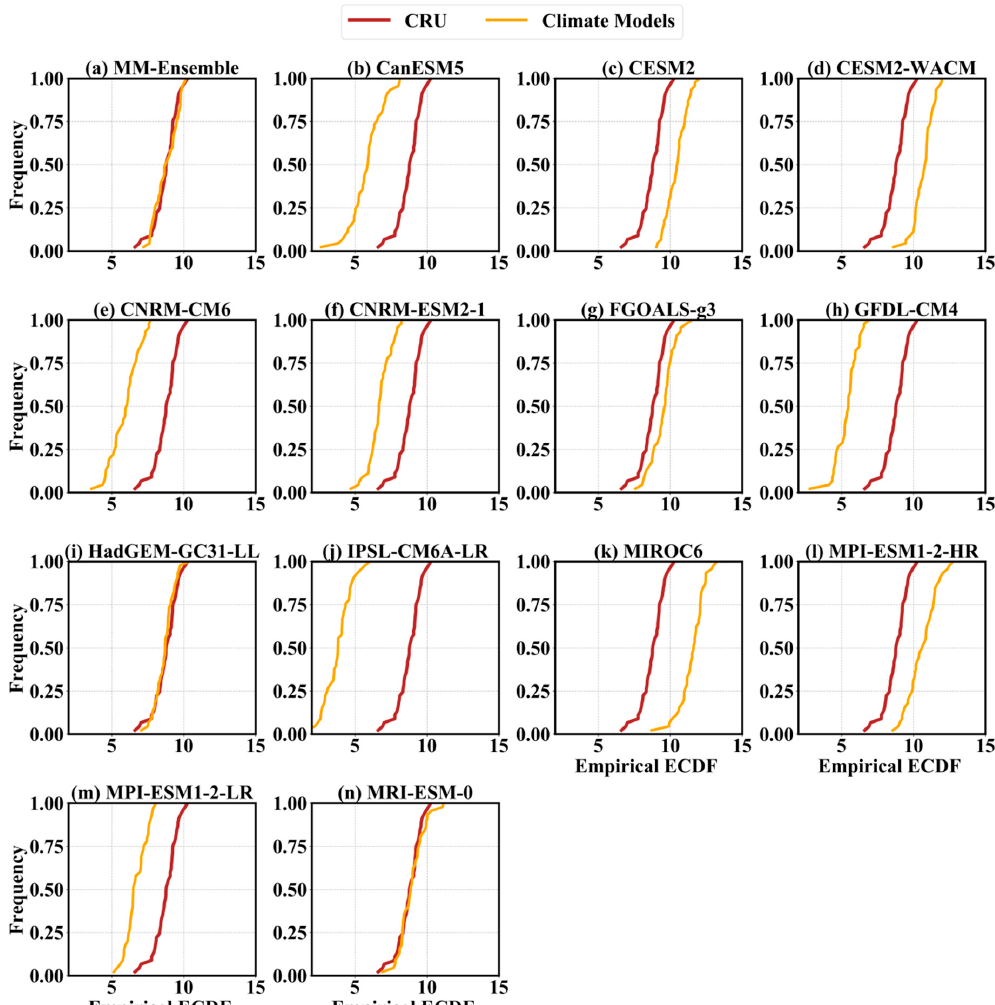
Figure 6. Same as Figure 5, but for winter (DJF) season.